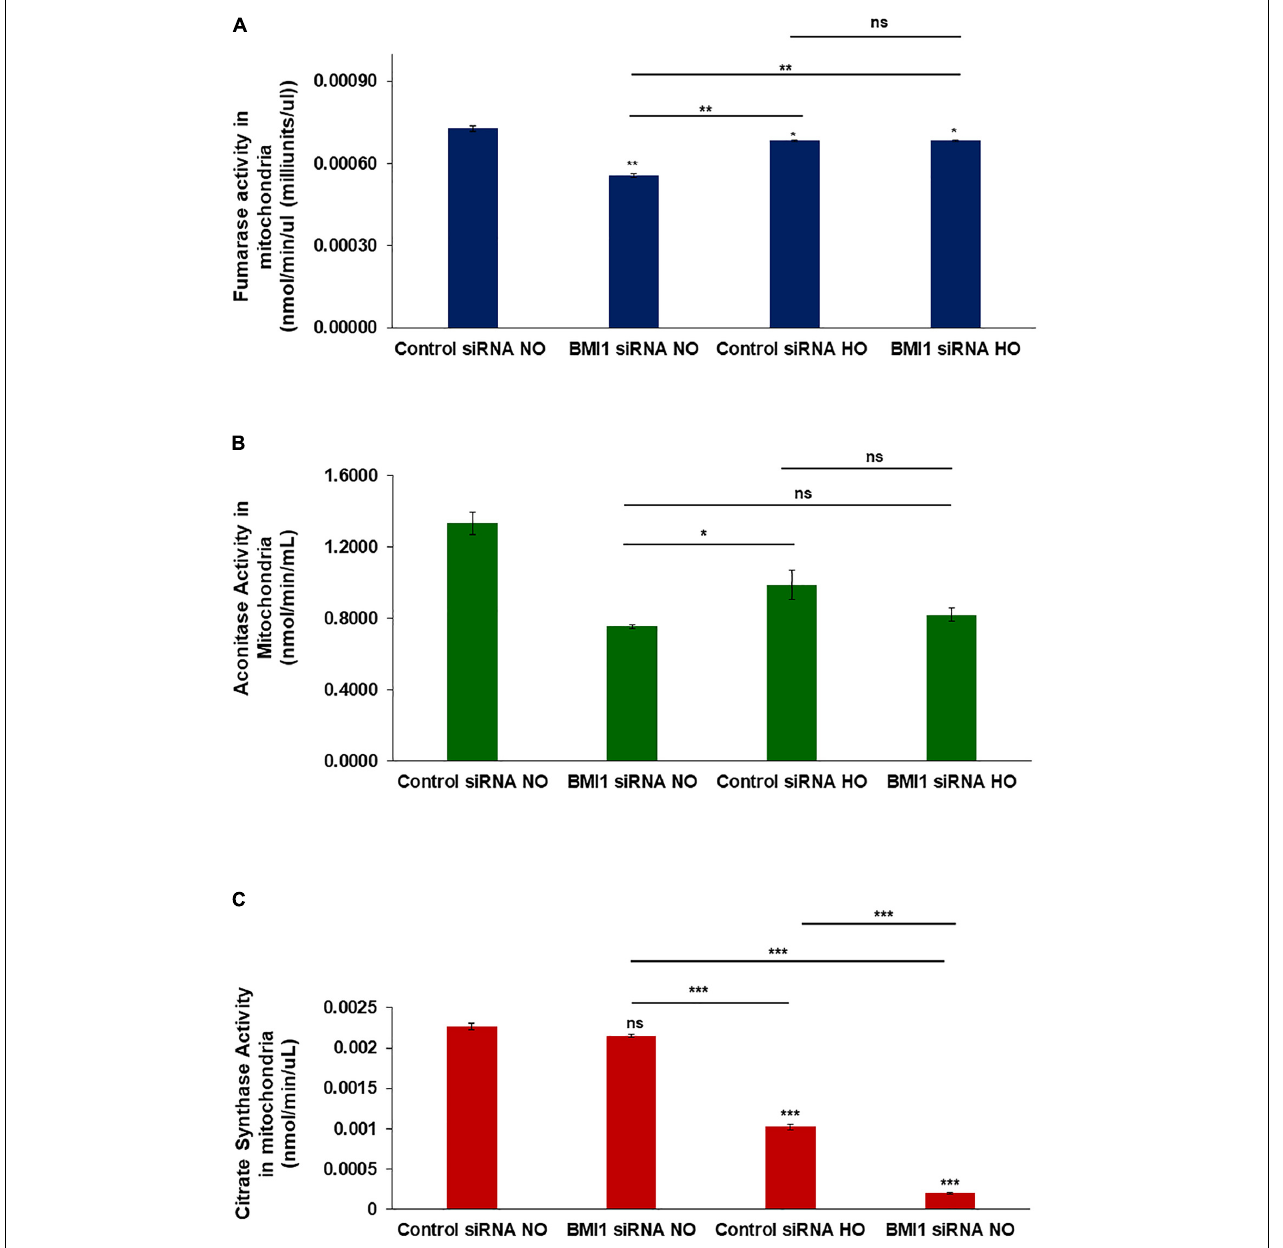
FIGURE 5 | Mitochondria enzymatic activity in BMI1 silenced H441 cells exposed to hyperoxia. (A) Fumarase activity (nmole/min/ µ L) in mitochondrial lysates from BMI1 silenced or non-silenced H441 cells exposed to normoxia and hyperoxia. (B) Aconitase activity (nmole/min/mL) in mitochondrial lysates from BMI1 silenced or non-silenced H441 cells exposed to normoxia and hyperoxia. (C) Citrate synthase (nmole/min/ µ L) in mitochondrial lysates from BMI1 silenced or non-silenced H441 cells exposed to normoxia and hyperoxia. n = 3, mean ± SEM; two-ways MANOVA ns = non-significant * p ≤ 0.05, ** p ≤ 0.01, *** p ≤